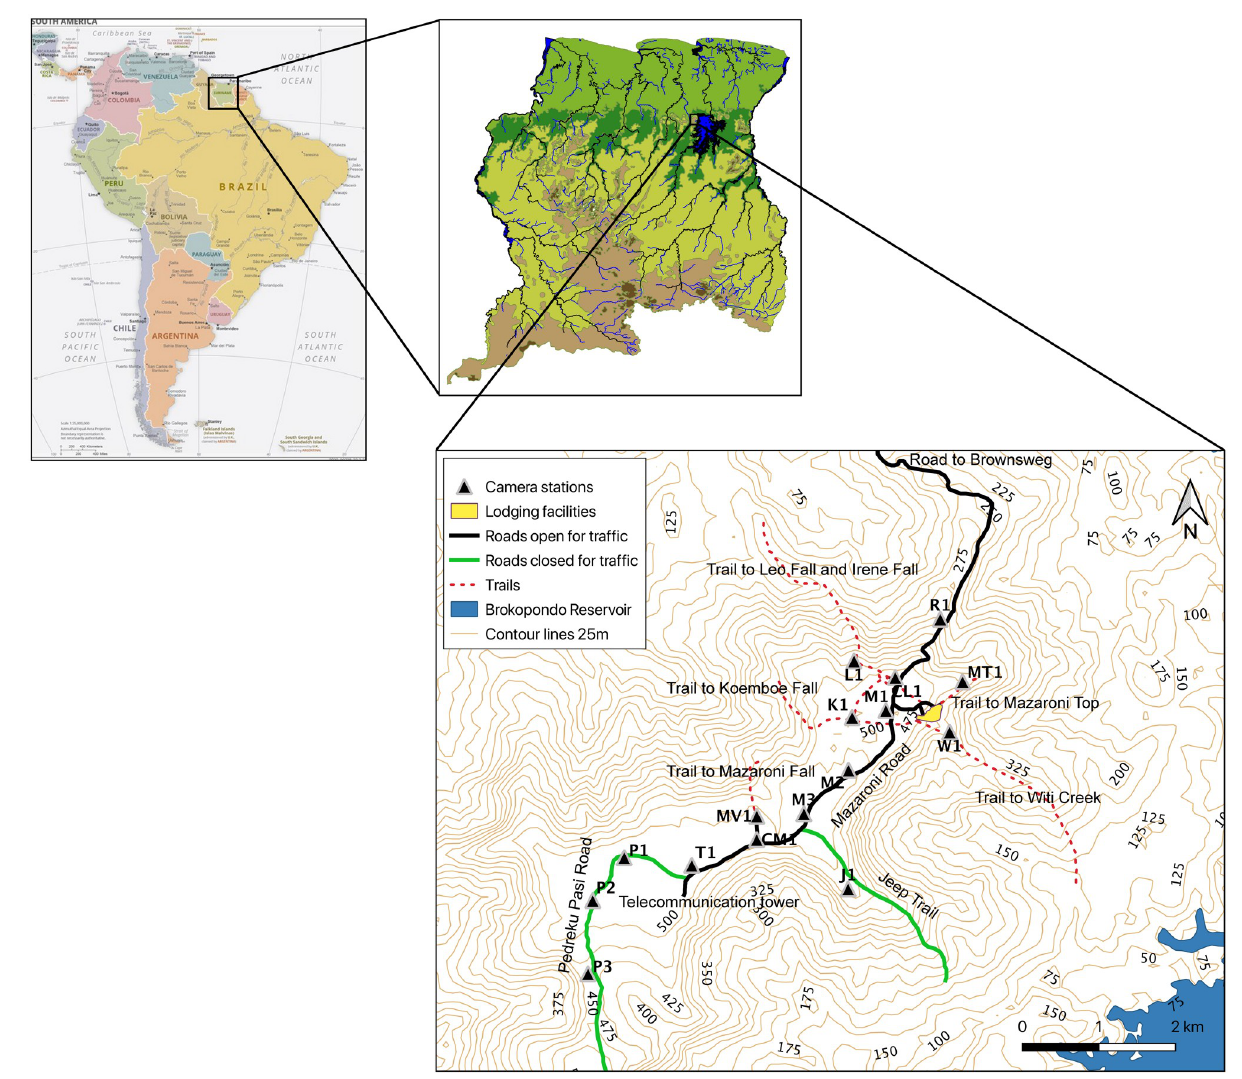
Fig 1. Location of the study area and camera trap